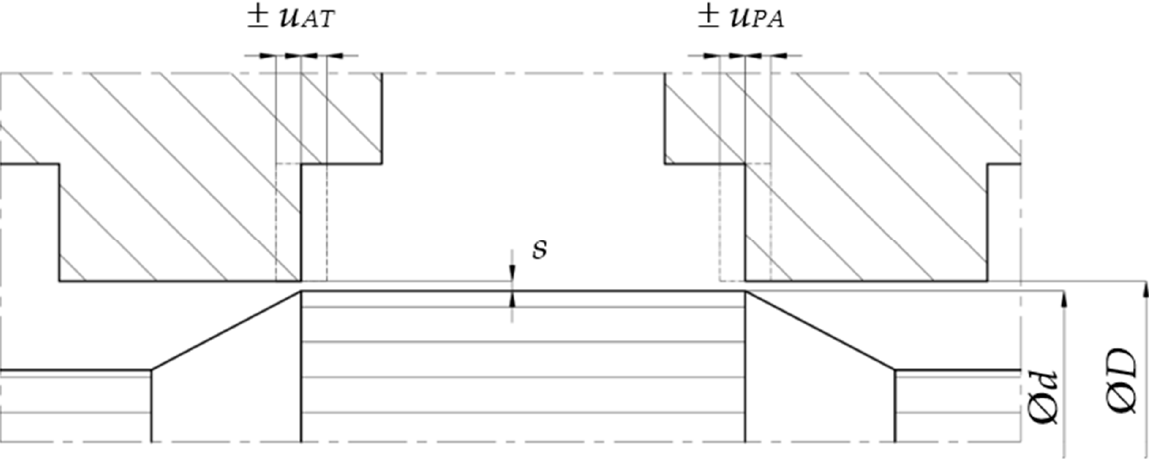
Figure 2. Detail of throttle edge geometry at zero spool lap.